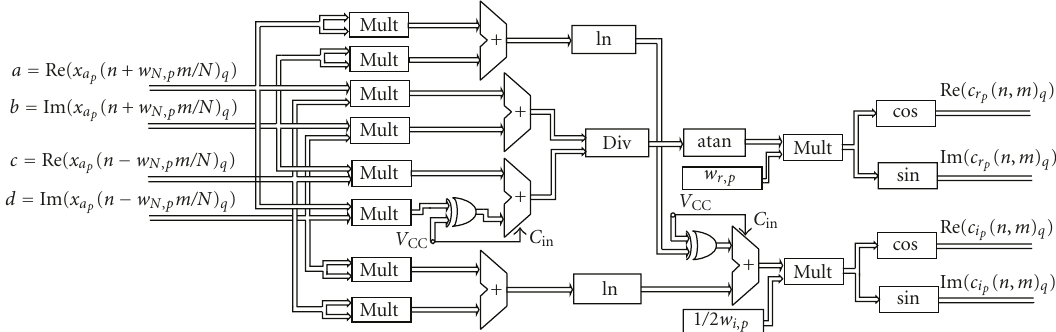
Figure 4: Architecture for realization of concentration functions c r